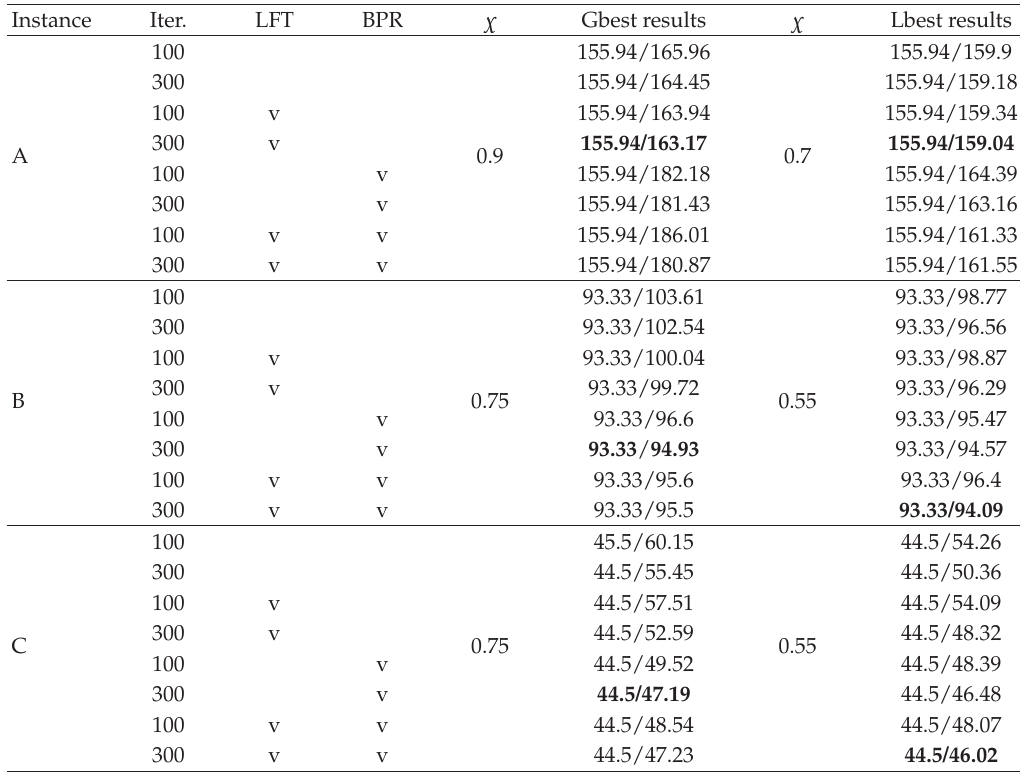
Table 13: Comparisons of experimental results.